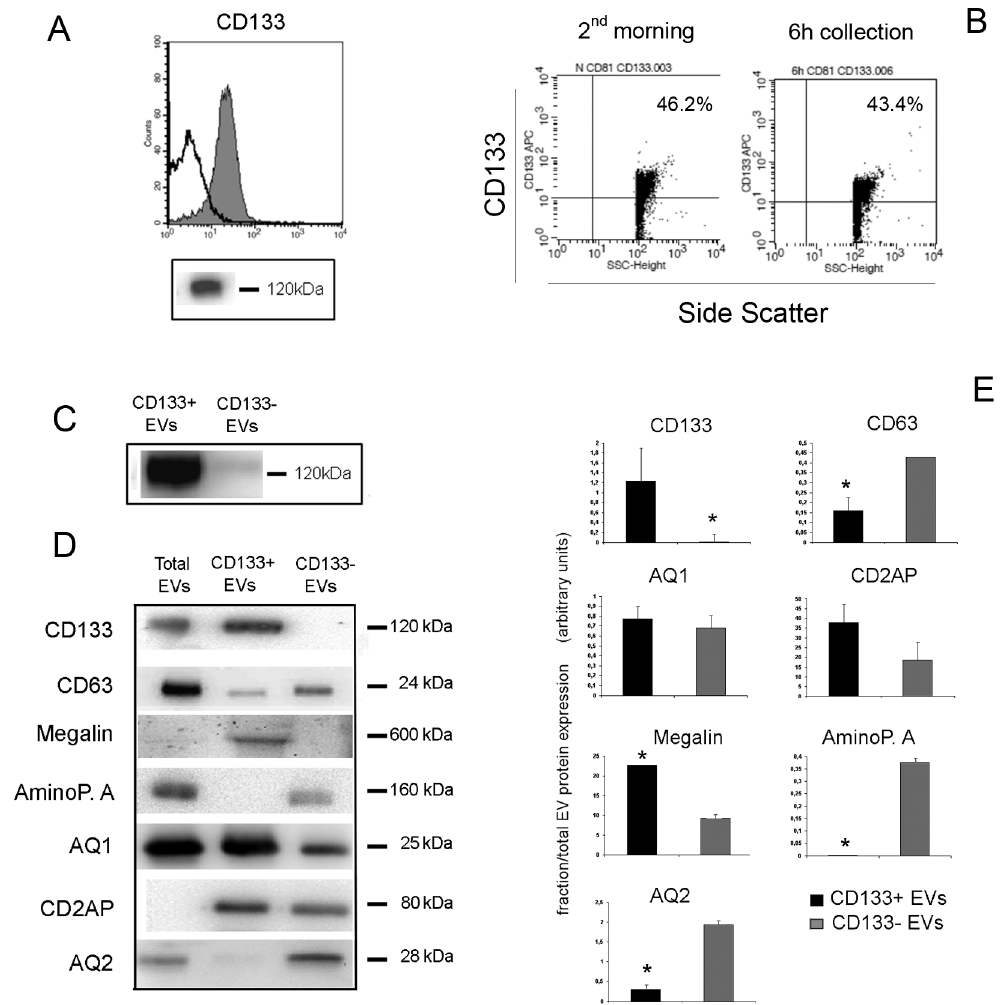
Figure 2. Expression of CD133 by urinary vesicles. Panel A. Representative cytofluorimetric and Western Blot (clone AC133) images of the expression of CD133 by urinary vesicles of normal subjects. The cytofluorimetric histogram shows CD133 detection (grey area) and isotypic control (dark line). Panel B . Scatter and fluorescence dot plots showing similar CD133 + EV levels in normal urine of a second morning minction or of a 6- hours collection. Plots are representative of three experiments with similar results. Panel C . Representative image of CD133 detection in CD133 + and CD133 2 sorted EVs (clone W6B3C1). Panel D and E . Representative images and quantification of the expression of different nephron markers by the total urinary EVs and by CD133 + and CD133 2 sorted EVs. Data are mean 6 SD of at least three different experiments and report the marker expression in the sorted fractions normalized on the expression in the Total EVs. AminoP.: Aminopeptidase A, AQ: Aquaporin, CD2AP: CD2 Associated protein. *=p ,